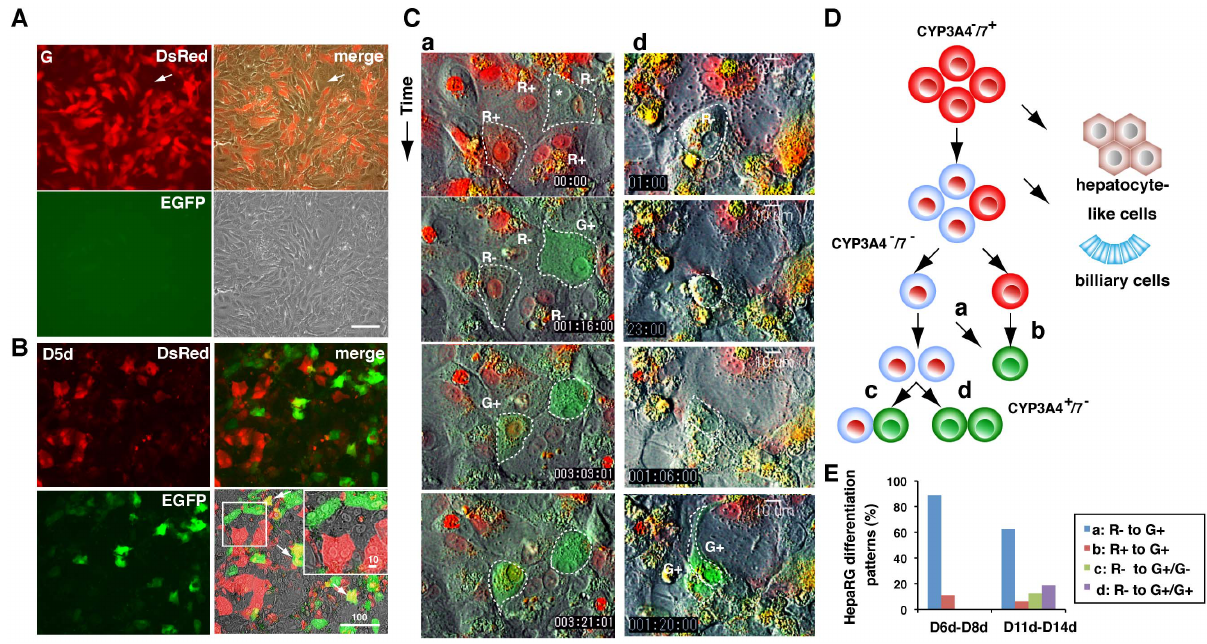
Figure 8. EGFP-positive cells do not always directly differentiate from DsRed-positive cells. (A) DsRed, EGFP, phase contrast, and merged images of transgenic HepaRG cells at the growing period (G). Undifferentiated transgenic HepaRG cells are blastic and DsRed-positive. Arrow indicates DsRed-negative cells. The size of the scale bar, 100 m m. (B) DsRed, EGFP, phase contrast, and merged images of transgenic HepaRG cells at D5d. EGFP-positive cells appear after most DsRed-positive cells have disappeared. Double-positive cells are rarely seen at D5d. Arrow indicates an exceptional double-positive cell. The size of the scale bar, 100 m m. Asterisk indicates a degenerated intracellular structure. (C) Sequential dual-color images from movies of HepaRG C3 cell differentiation between D6d and D14d. (a) A DsRed-positive cell (R + ) becomes non-fluorescent (R-) and then EGFP-positive (G + ); (d) a non-fluorescent cell divides into two cells, both of which are EGFP-positive. (D) A model for the course of hepatic cell differentiation from CYP3A7-expressing hepatoblastic precursors. Following differentiation of transgenic HepaRG cells, there is a colorimetric shift from red to green, which is separated by a period in which cells are not fluorescent without (a) or with (c and d) cell division. (E) Frequencies of EGFP- positive cells that differentiated through process a, b, c, or d between D6d and D8d or between D11d and